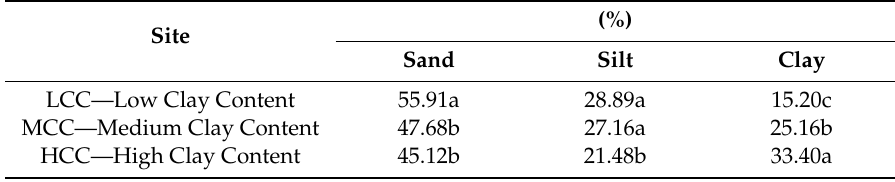
Table 1. Physical attributes of soil in three areas with a clay gradient.